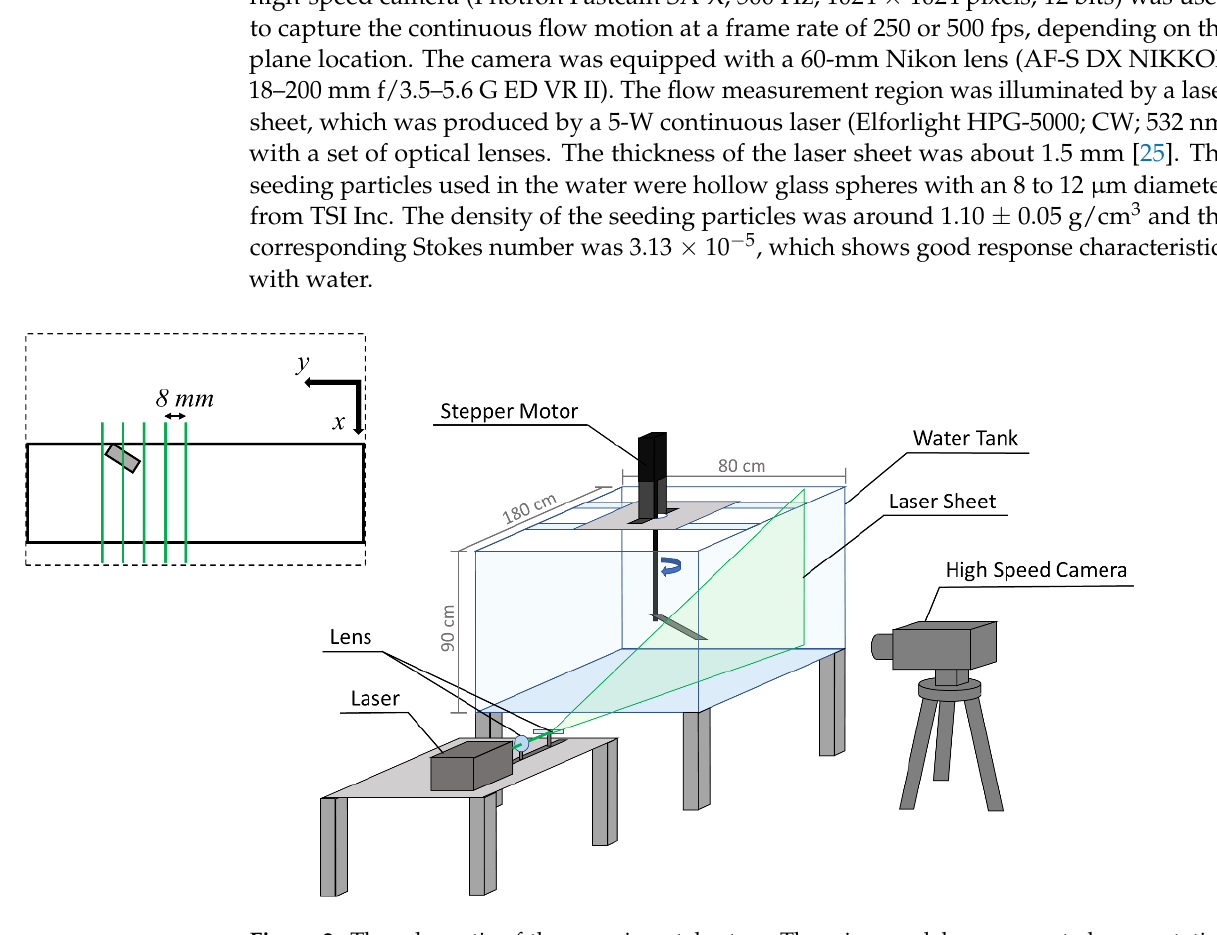
Figure 2. The schematic of the experimental setup. The wing model was mounted on a rotating device and put into a water tank accompanied by a PIV measurement system.